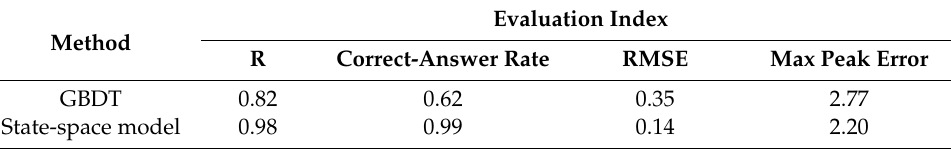
Table 9. Evaluation indices for each method (May to October